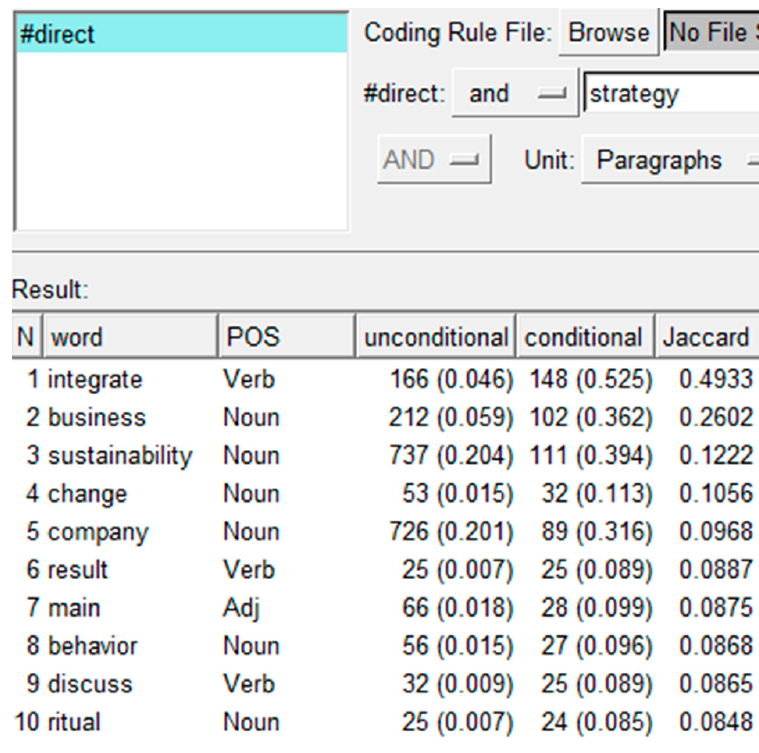
Figure 5. Strategy word association.